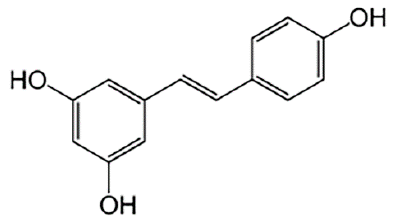
Figure 1. Chemical structure of resveratrol.